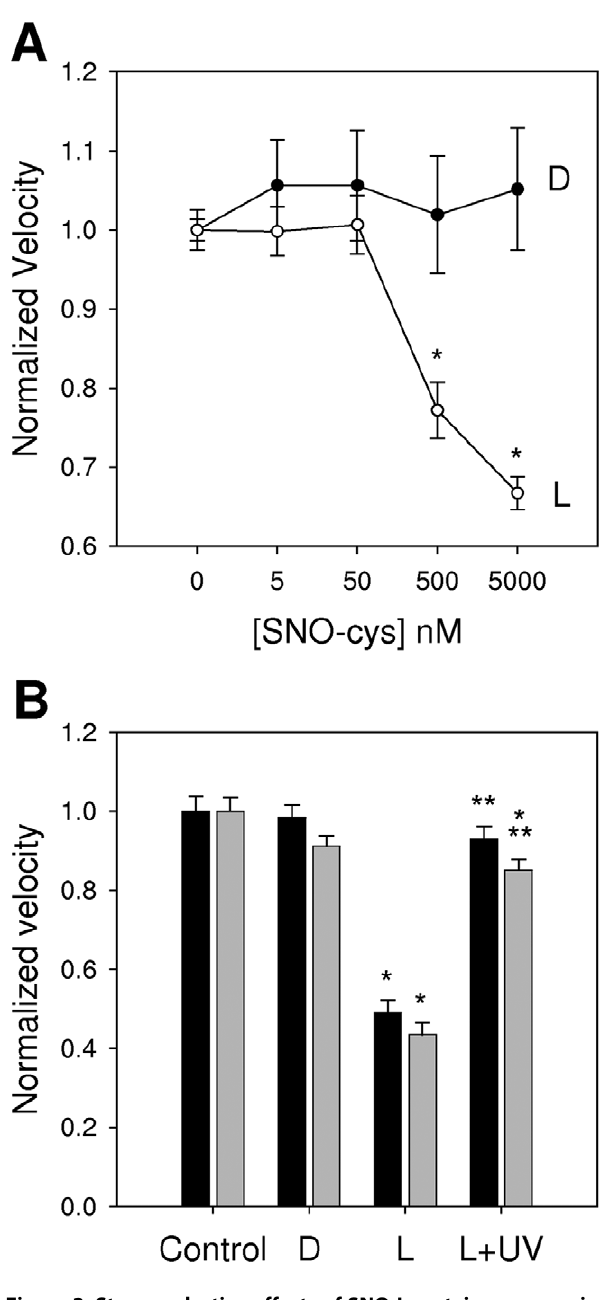
Figure 3. Stereo-selective effects of SNO-L-cysteine on myosin. A: Dose-response showing that SNO-L-cysteine, the naturally occurring isomer, has pronounced effects on actin filament velocity, while SNO-D- cys does not. B: Effects of 5 m M L- and D-isomers of SNO-cys on actin filament velocities over skeletal (dark bars) and cardiac (light bars) myosin, and recovery by exposure to ultraviolet light – strong support of nitrosylation as the underlying modification. *Different from control (p , 0.05). **Different from SNO-L-cys alone (p , 0.05).